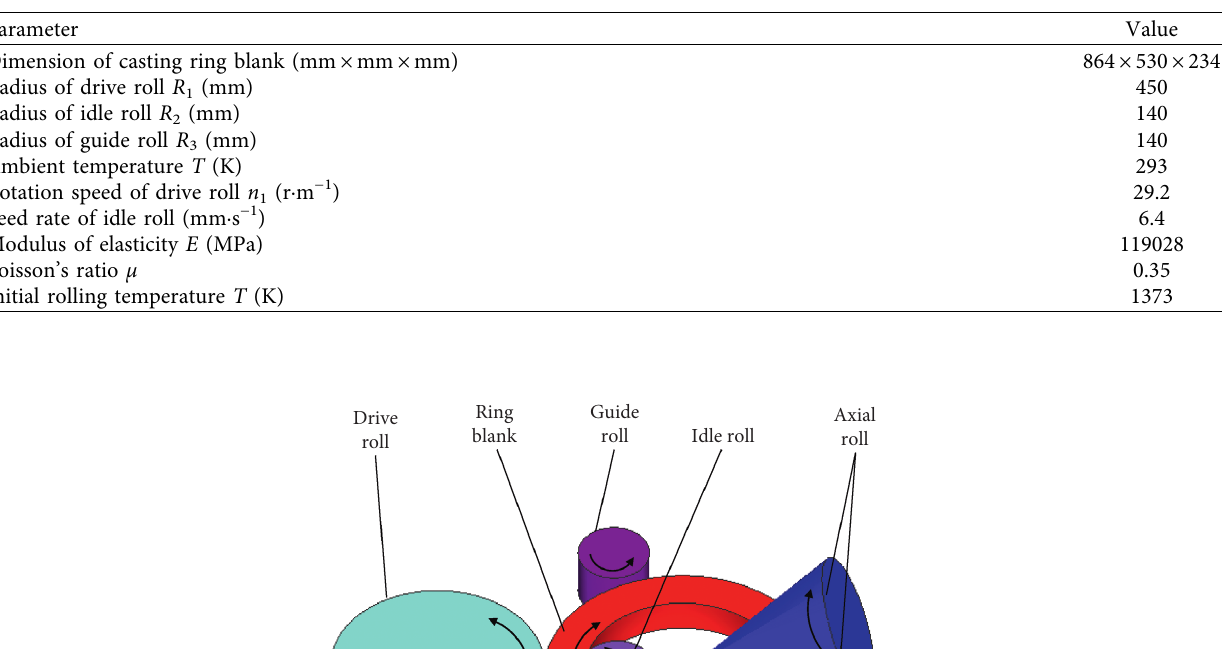
Table 3: Process parameters used in simulation.